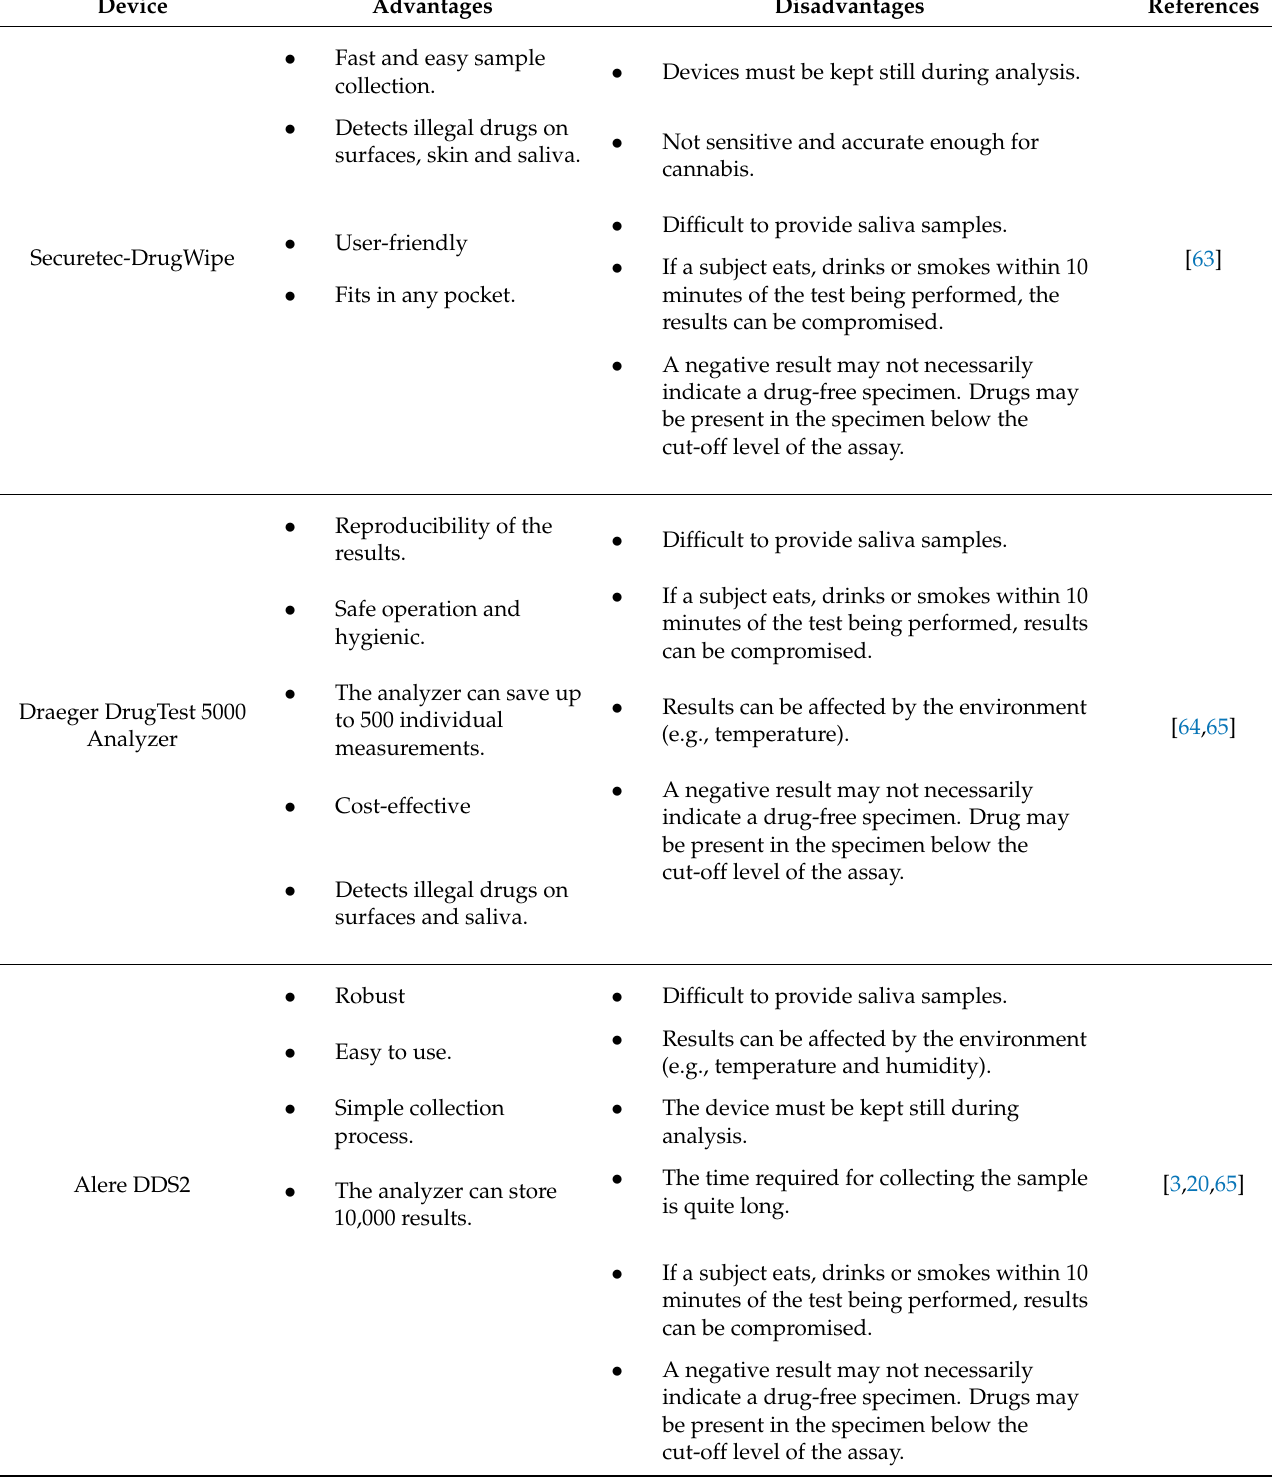
Table 2. Some of the advantages and disadvantages of on-site drug systems.